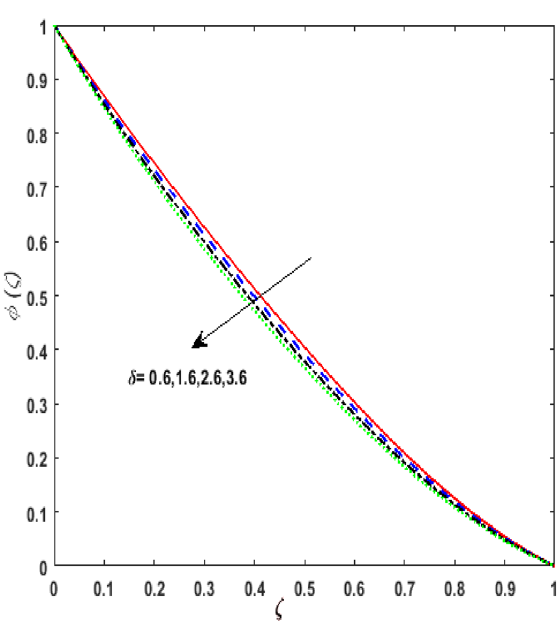
Figure 16. Effect of chemical reaction parameter δ on concentration φ(ζ)